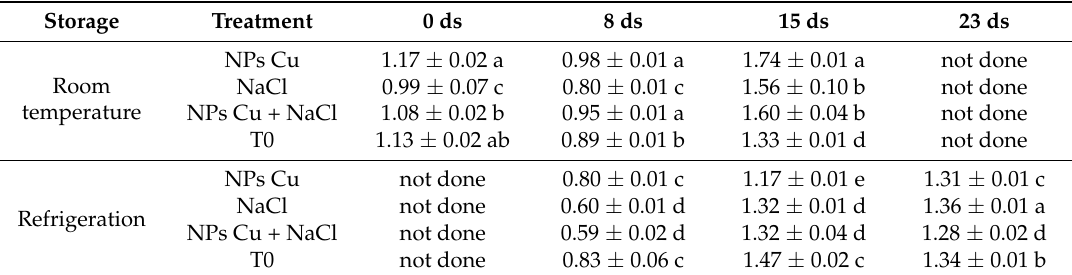
Table 4. β -carotene content (milligrams per 100 g fresh weight) in tomato fruits at different storage times at room temperature (24 ± 1 ◦ C) and refrigeration (4 ± 1 ◦ C and relative humidity at 80%).